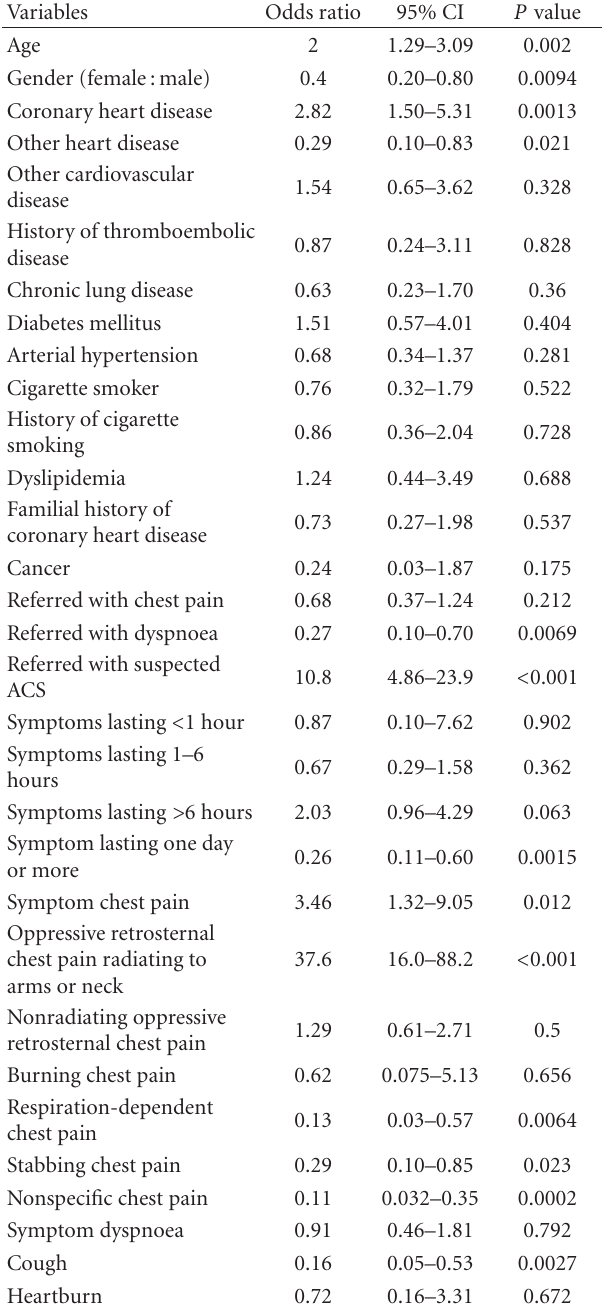
Table 3: Logistic regression models for each variable separately on